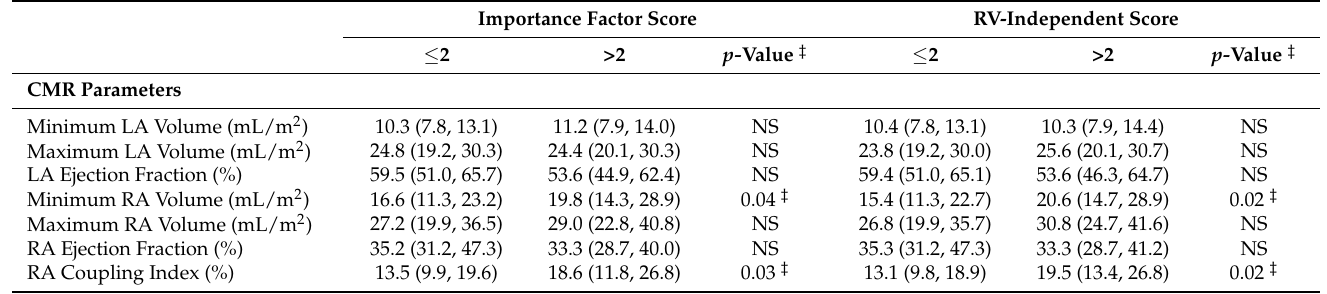
Table 4. Associations of atrial measurements with Importance Factor Scores and RV-Independent Scores * ,† .